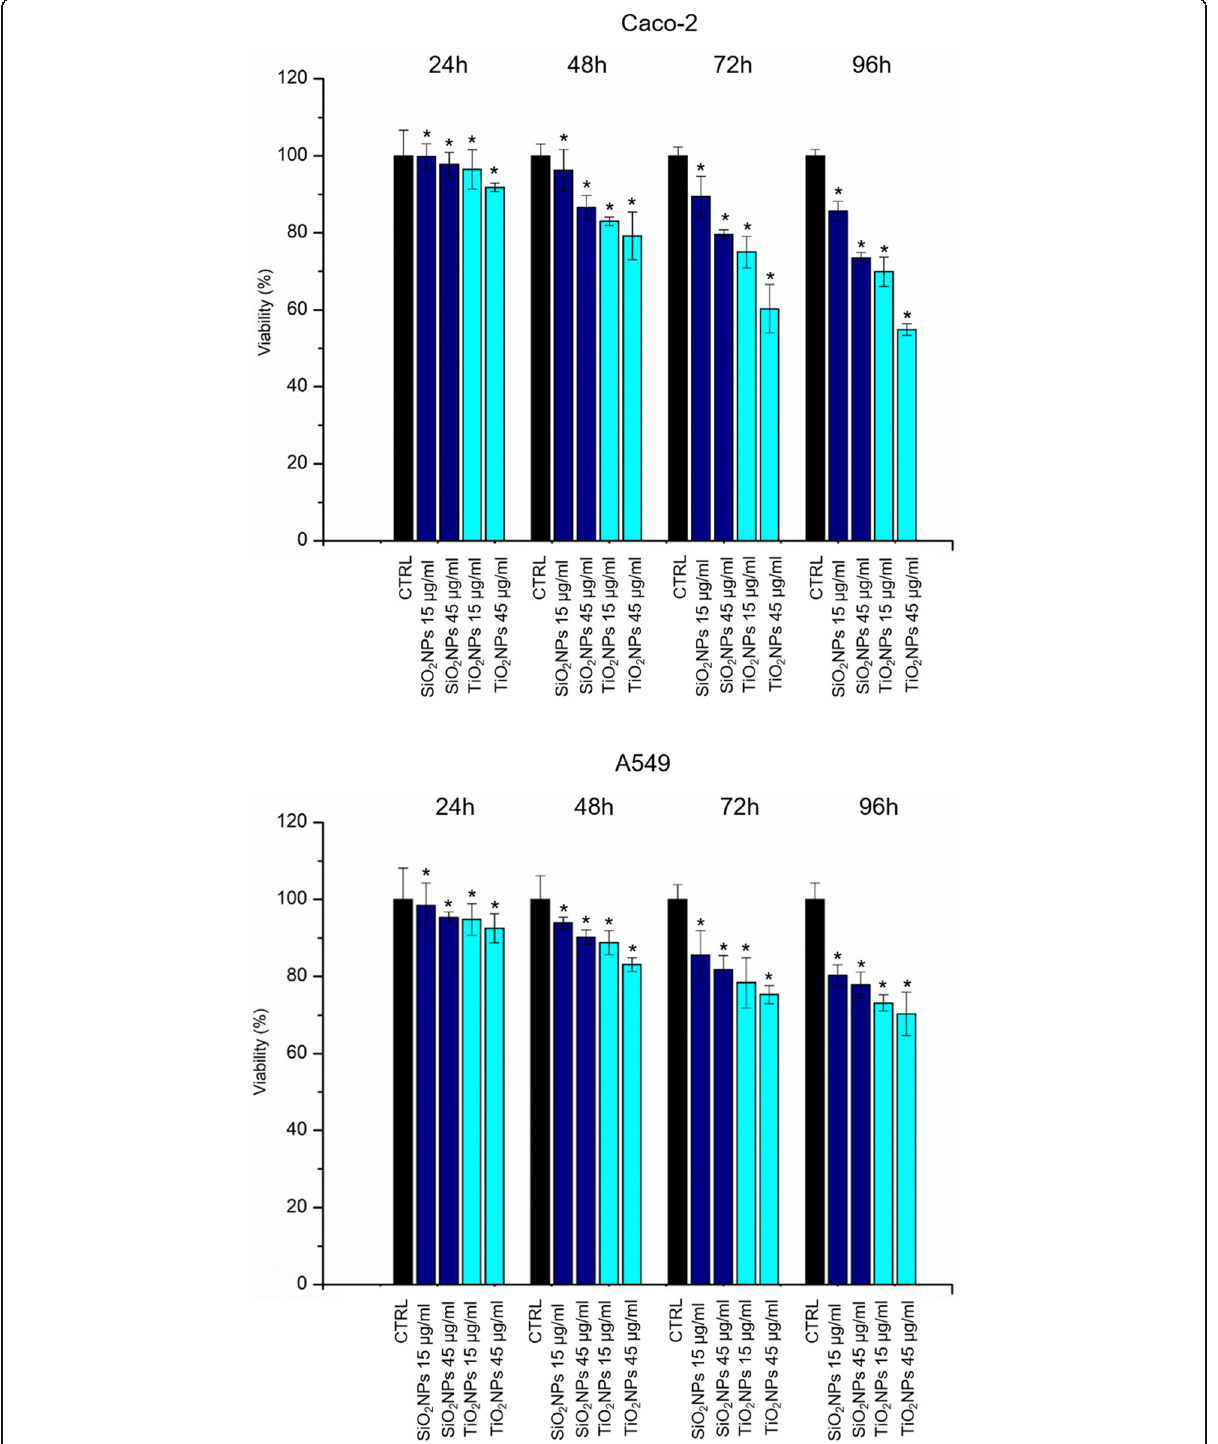
Fig. 3 Viability assay (WST-8) of Caco-2 ( a ) and A549 ( b ) cells after 24 h, 48 h, 72 h, and 96 h of exposure to two doses (15 μ g/ml and 45 μ g/ml) of TiO 2 NPs and SiO 2 NPs. Viability of NP-treated cells was normalized to non-treated control cells. As positive control (P), cells were incubated with 5% DMSO (data not shown). Data reported as mean ± SD from three independent experiments are considered statistically significant compared with control ( n = 8) for p value < 0.05 (< 0.05*, < 0.01**, and <